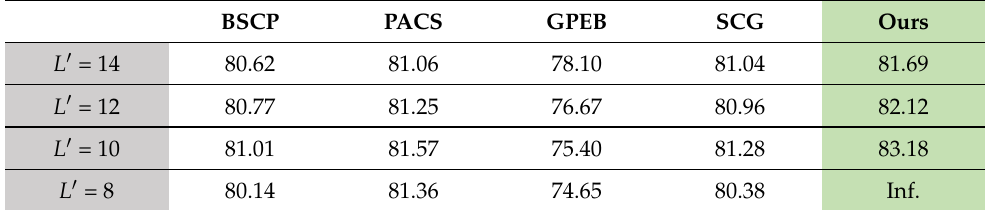
Table 7. SNR results (dB) of a 16-bit FWBM for various TEC schemes and L ′ -bit inputs.